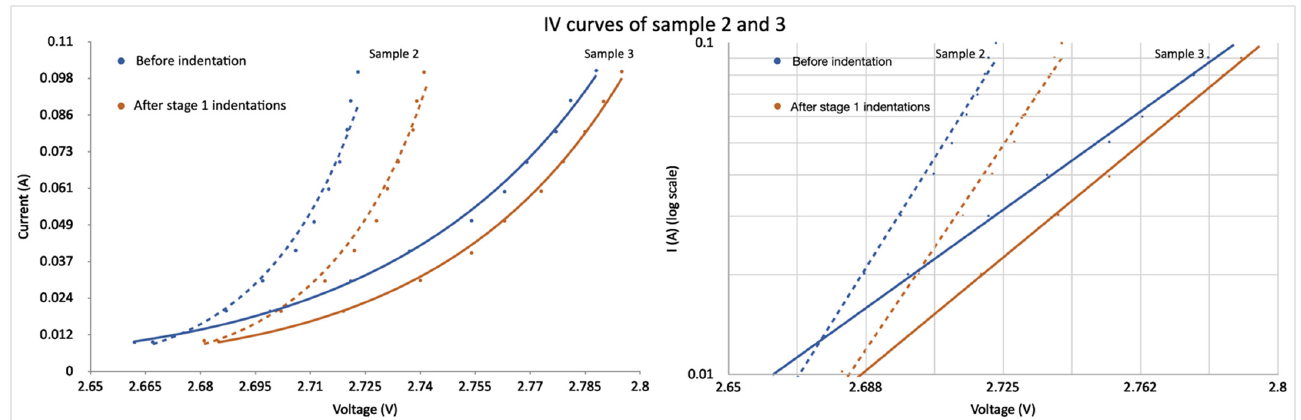
Figure 6. IV curves of Samples 2 and 3. Dashed lines show IV data from Sample 2 before and after first indentation stage, and solid line corresponds to Sample 3. Notice the change of slope between samples in the log plot. Sample 3 was edge-polished in a direction with 𝜃 (cid:3404) 90° relative to the c-axis and